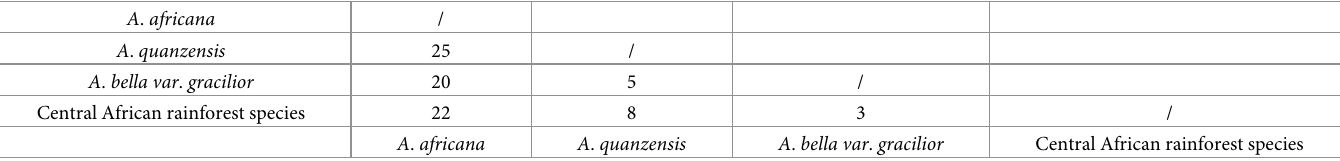
Table 3. SNP variation in plastid intron regions among Afzelia species. “Central African rainforest species” indicates A . bella var . bella , A . bipindensis and A . pachyloba .